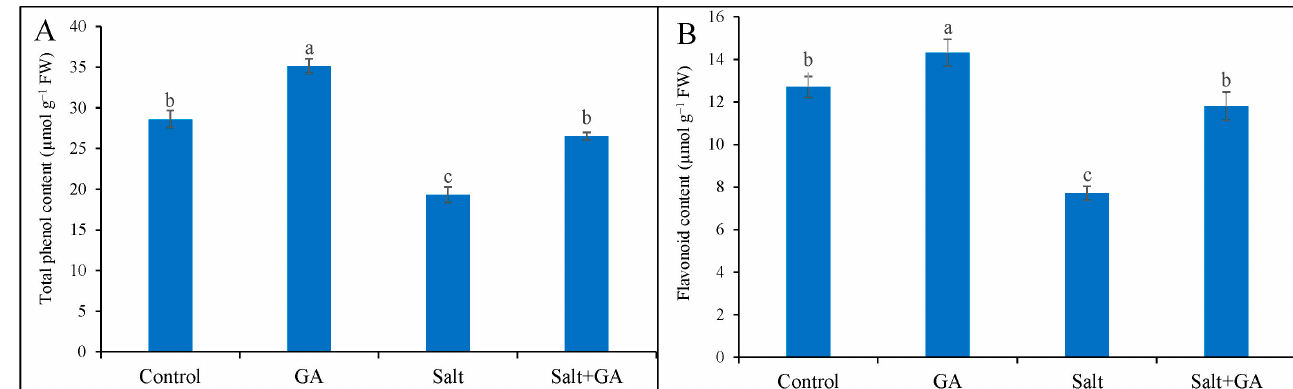
Figure 5. Phenolic compounds (total phenol, ( A ) and flavonoid contents, ( B )) of salt-treated rice ( O. sativa L. cv. BRRI dhan52) seedlings as influenced by GA supplementation. 1 mM gallic acid and 200 mM NaCl are specified by GA and salt, correspondingly. Values with different letters are significantly different at P ≤ 0.05 applying the Tukey’s HSD test.